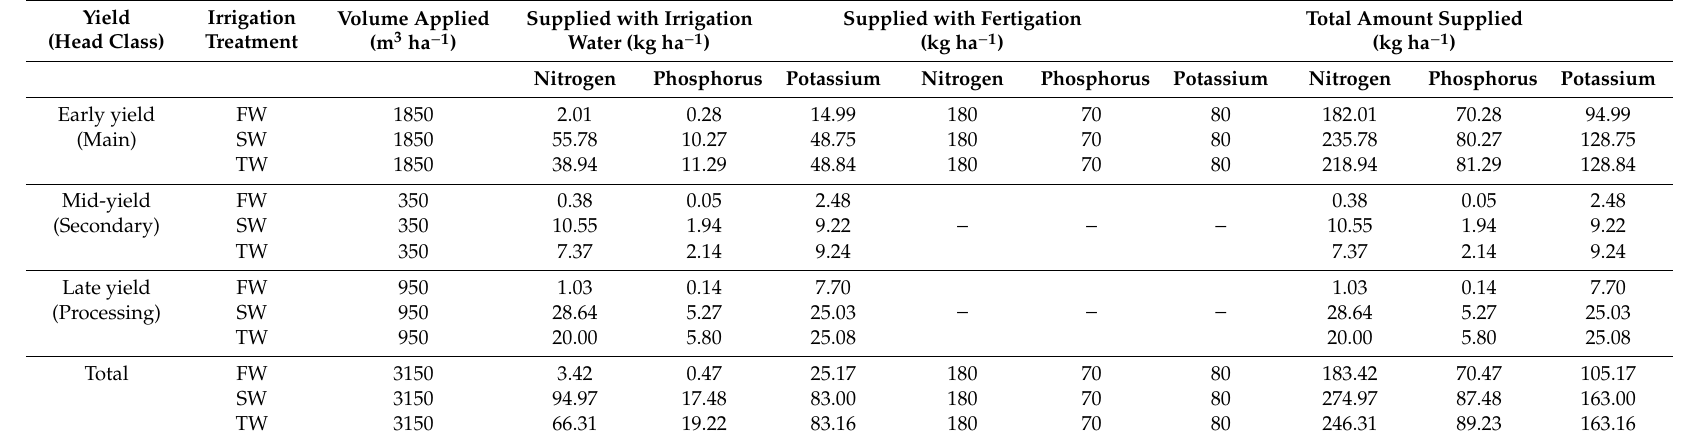
Table 1. Supply of mineral nutrients to the soil through the fertigation and the di ff erent irrigation water